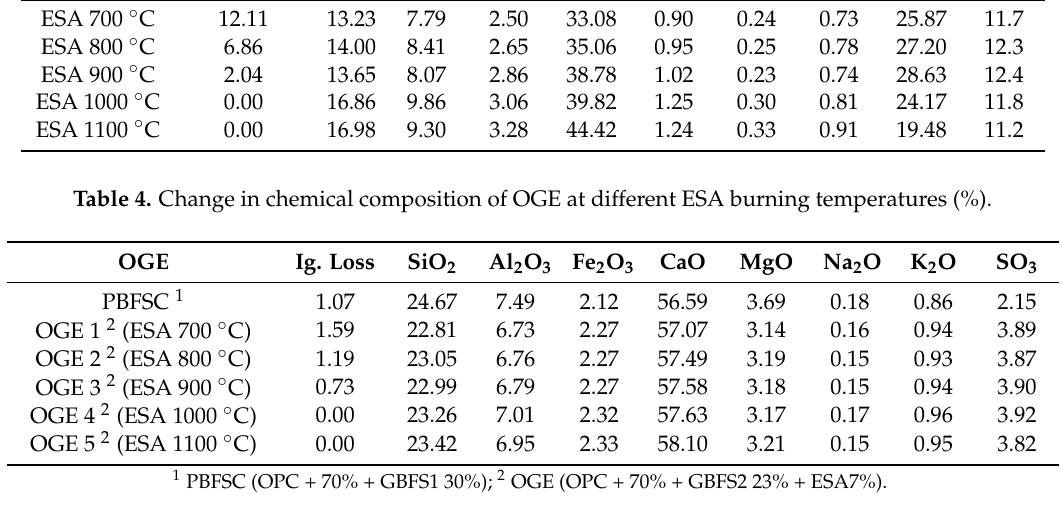
Table 3. Change in chemical composition at different ESA burning temperatures (%). ESA